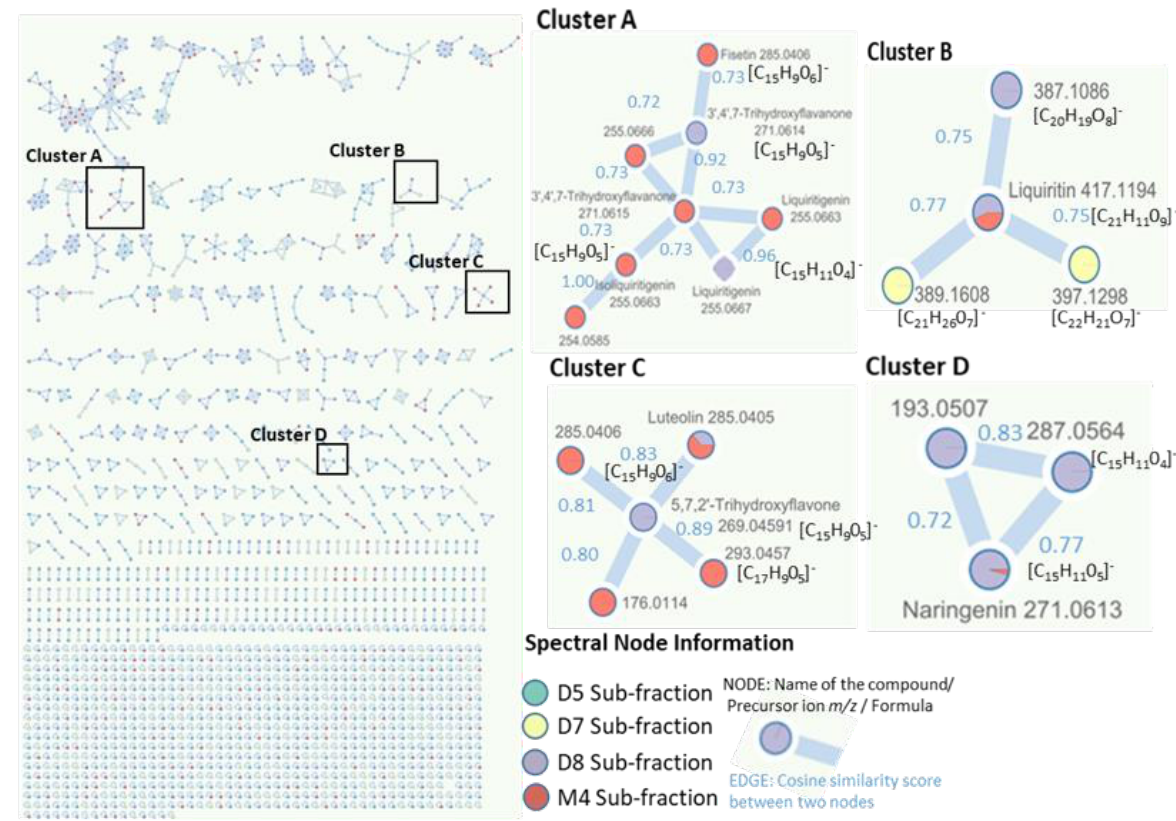
Figure 9. Molecular networking of the D5-8 and M4 sub-fractions as a complementary method to the targeted and untargeted analysis.